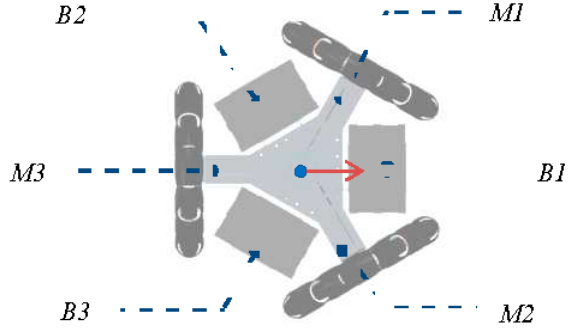
Figure 6. Batteries (B1, B2 and B3) and main DC motors (M1, M2 and M3) at the base of the APR.